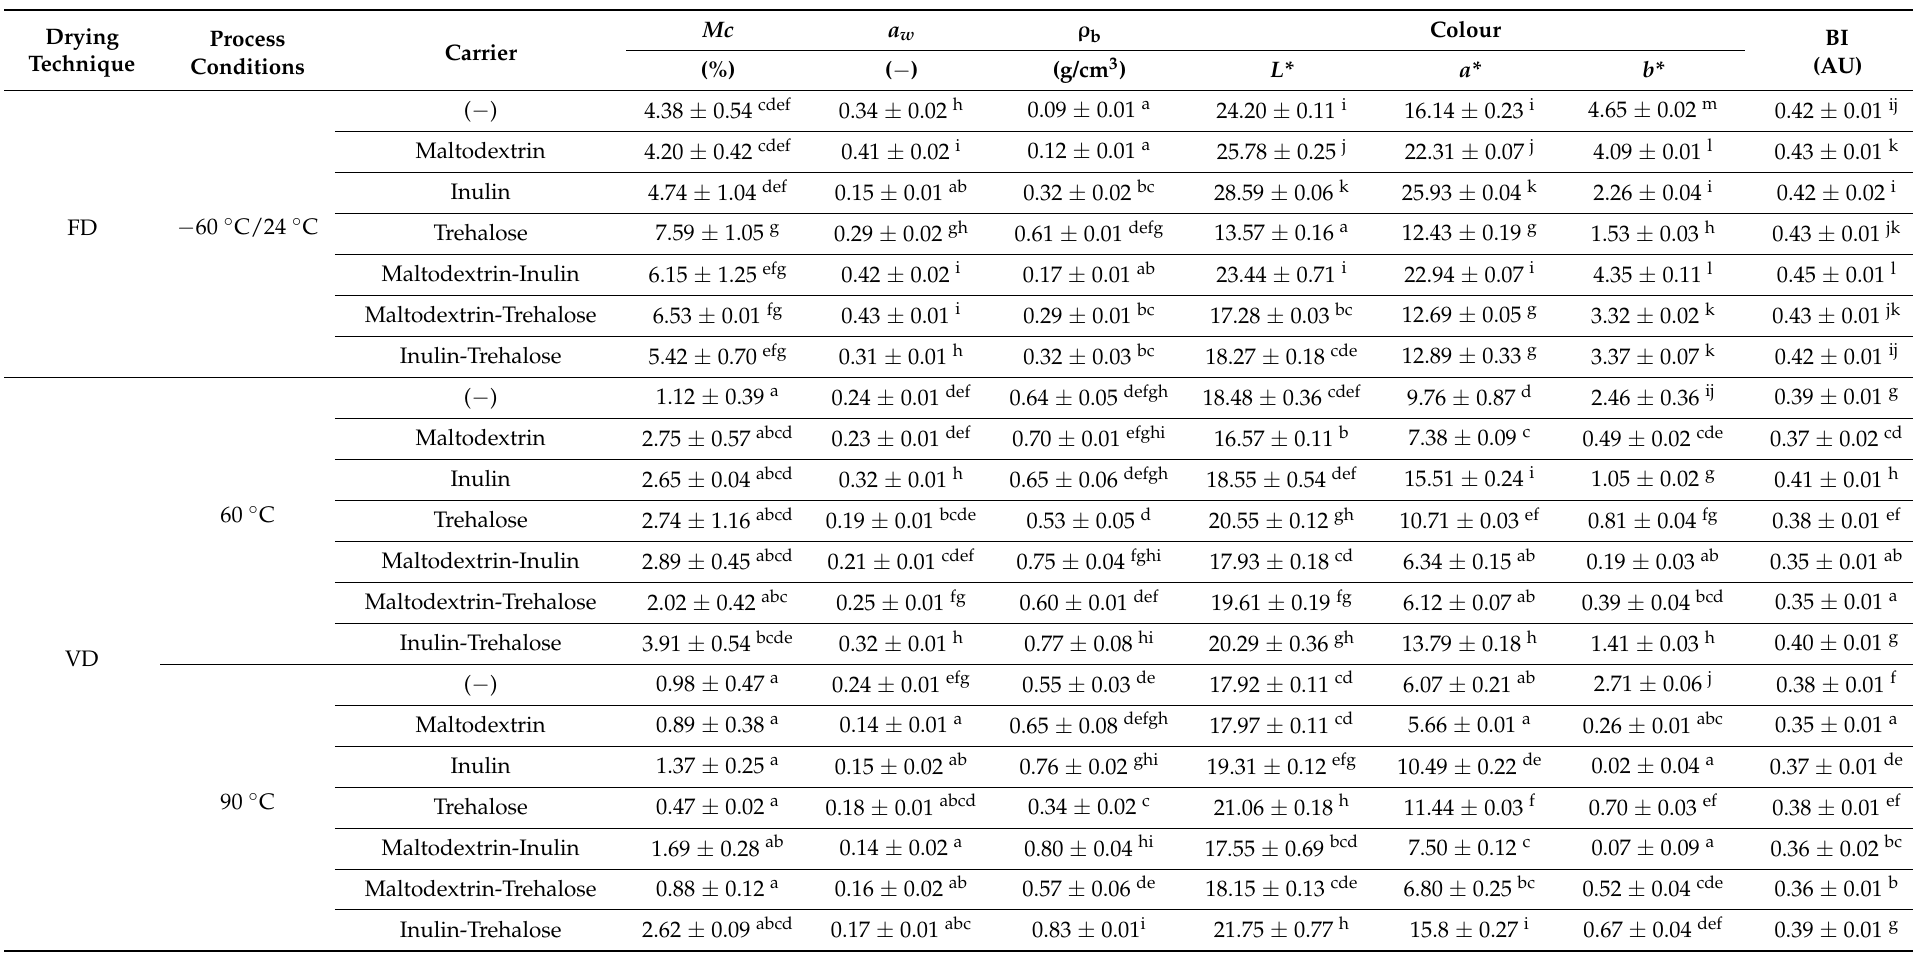
Table 1. Moisture content, water activity, bulk density, colour (CIE L*a*b* ), and browning index of chokeberry powders obtained after freeze and vacuum drying ( n = 2; average ± standard